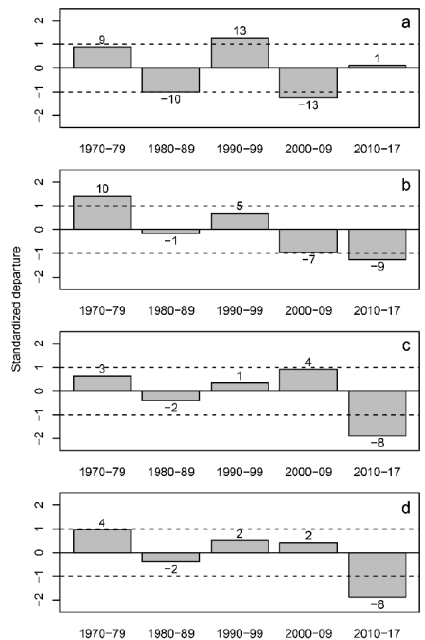
Figure 4. Decadal departure of rainfall in ( a ) headwater, ( b ) upper, ( c ) middle and ( d ) entire Bagmati catchments. Note: labels associated to the bars represent percentage of departure in relation to long-term mean.